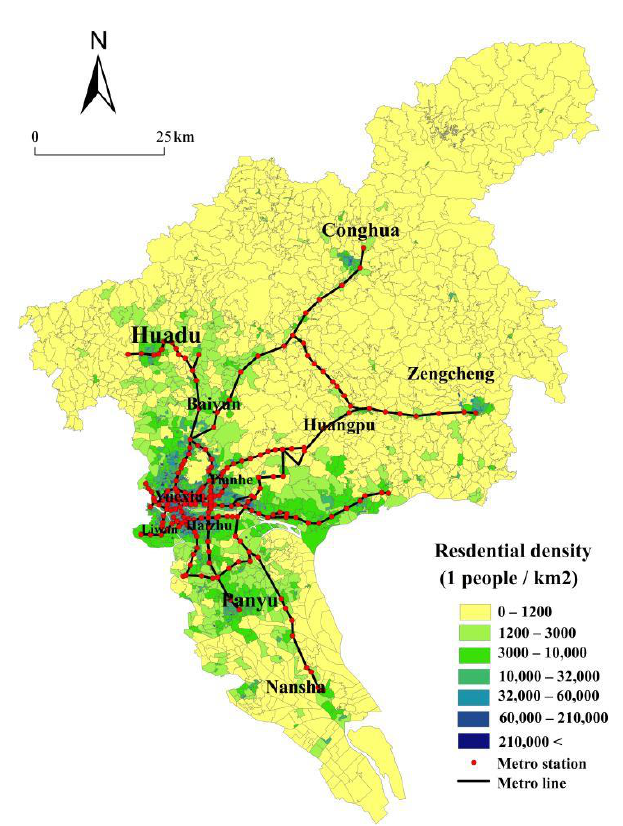
Figure 1. The spatial distribution of residential density and major commercial complexes in